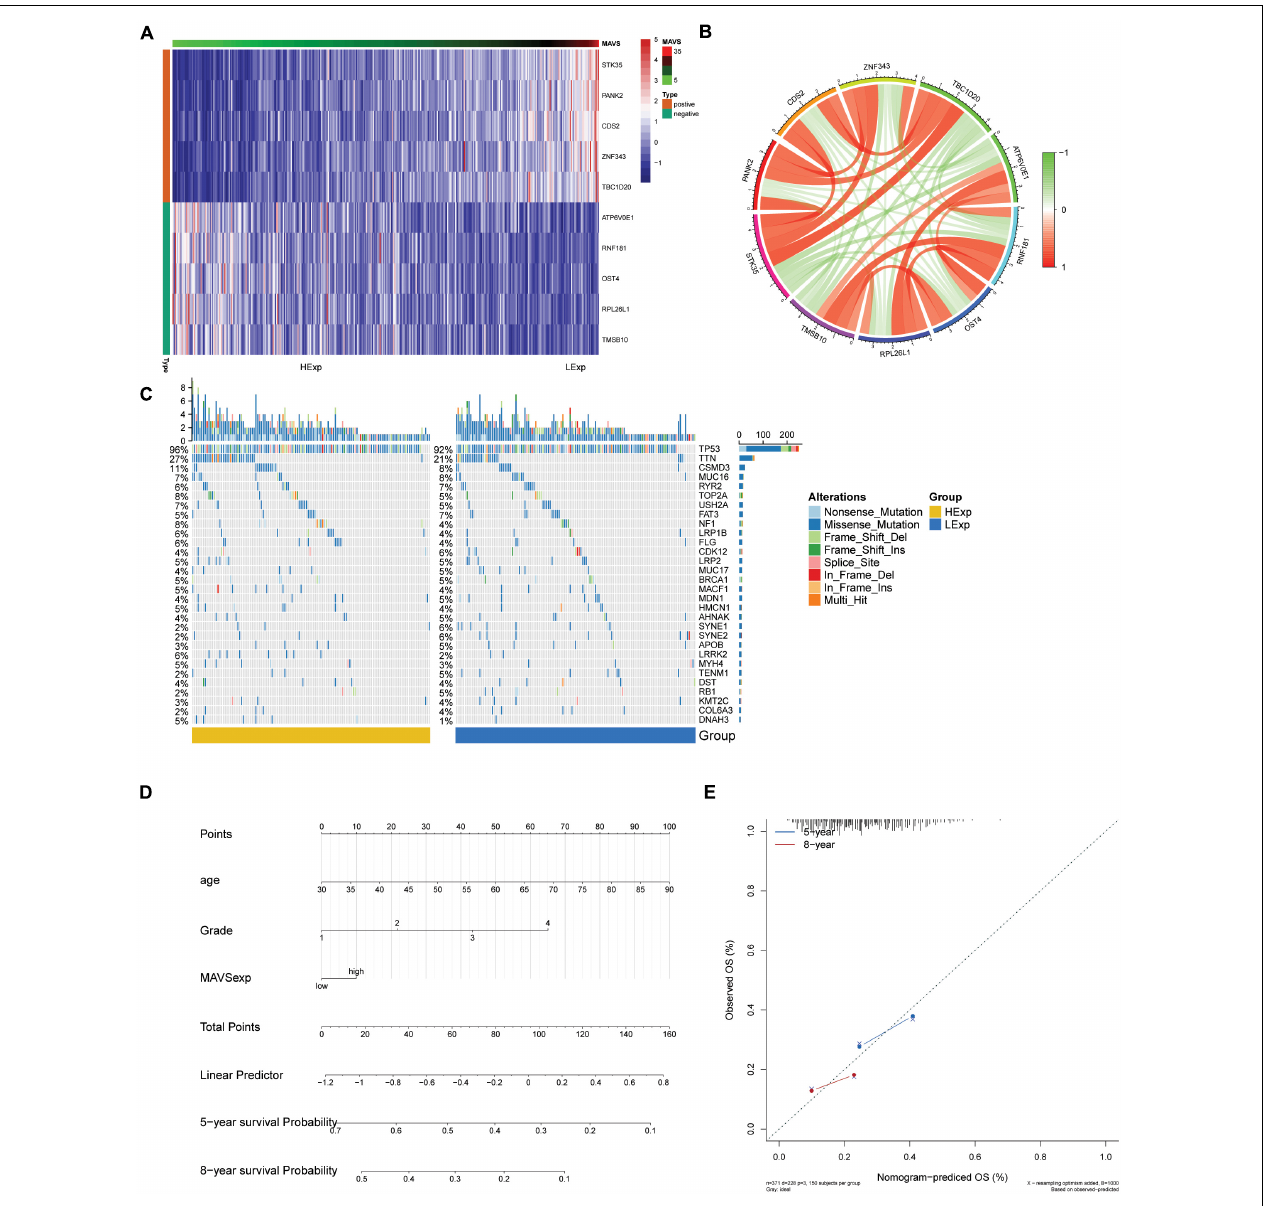
FIGURE 2 | Significant MAVS-related genes or mutation genes in OC obtained by co-expression analysis and mutation analysis. (A) Heat map shows the top 10 genes that are differentially expressed in groups with positive or negative MAVS expressions of OC patients. (B) Network visualization of significant MAVS-related genes in groups with positive or negative MAVS expressions of OC patients. (C) Heat map of the MAVS-related mutation genes in OC obtained by mutation analysis. (D) Nomogram for predicting the 3- and 5-year survival rates of OC patients. (E) Calibration curve based on the 3-year OS of the